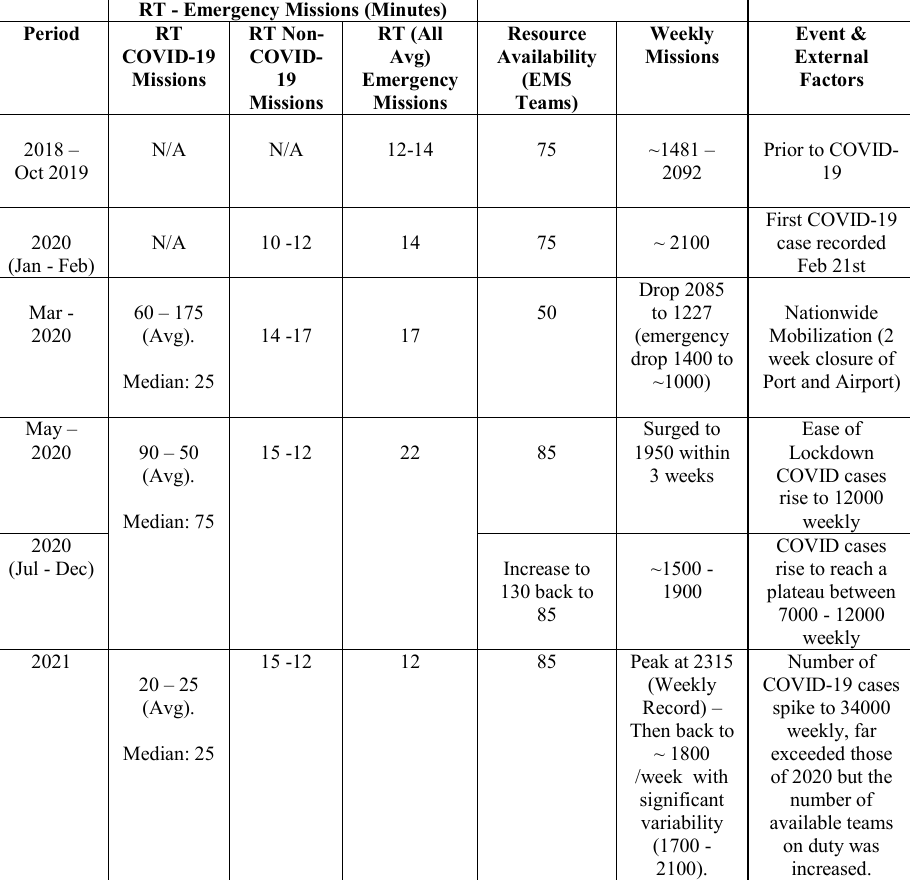
Table 4. Summative side by side of RT - Emergency Missions; Resource availability; Events RT - Emergency Missions (Minutes)